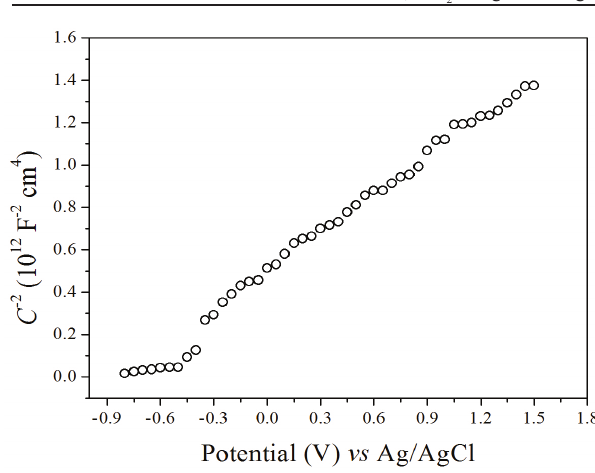
Fig. 4 – Mott-Schottky plot of TiO